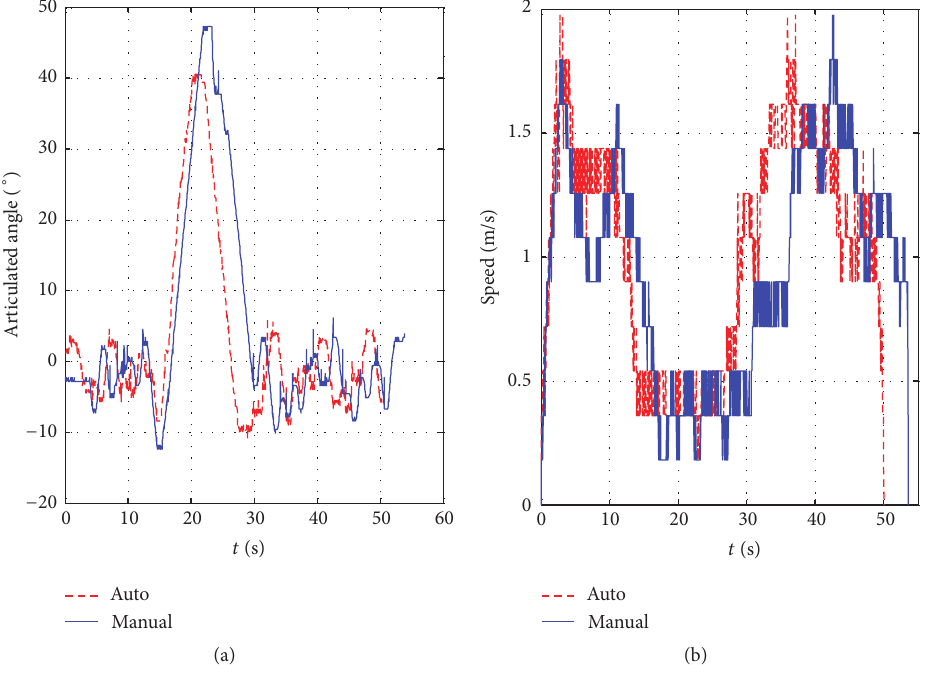
Figure 13: Driving experiment